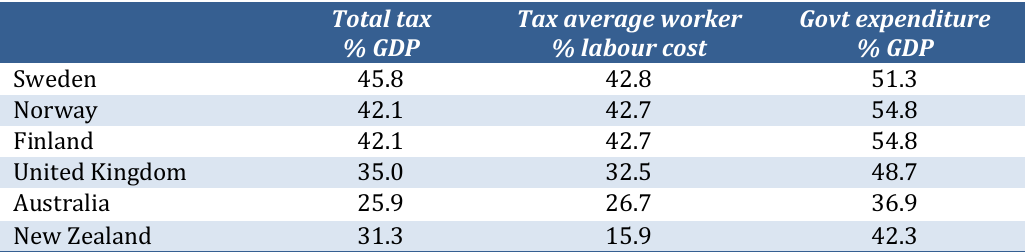
Table 1: Comparative taxation revenues: Nordic and Anglo clusters